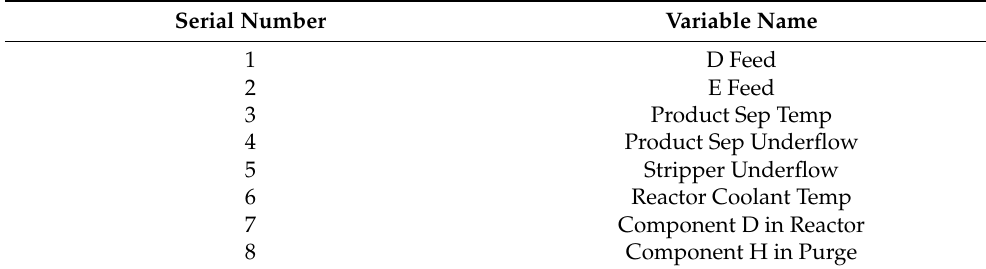
Table 1. Eight process continuous variables in TE process.